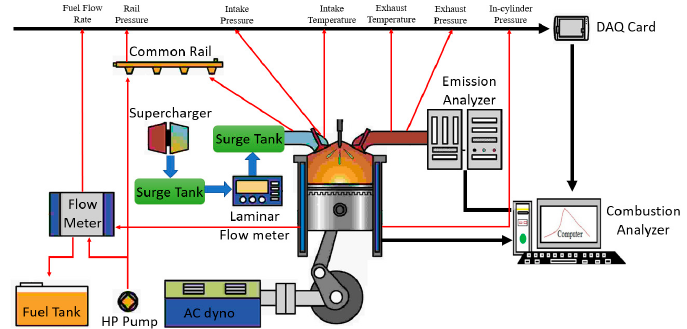
Figure 4. High-speed HD diesel engine and the schematic of test setup. Figure 4. High ‐ speed HD diesel engine and the schematic of test setup . Figure 4. High ‐ speed HD diesel engine and the schematic of test setup .